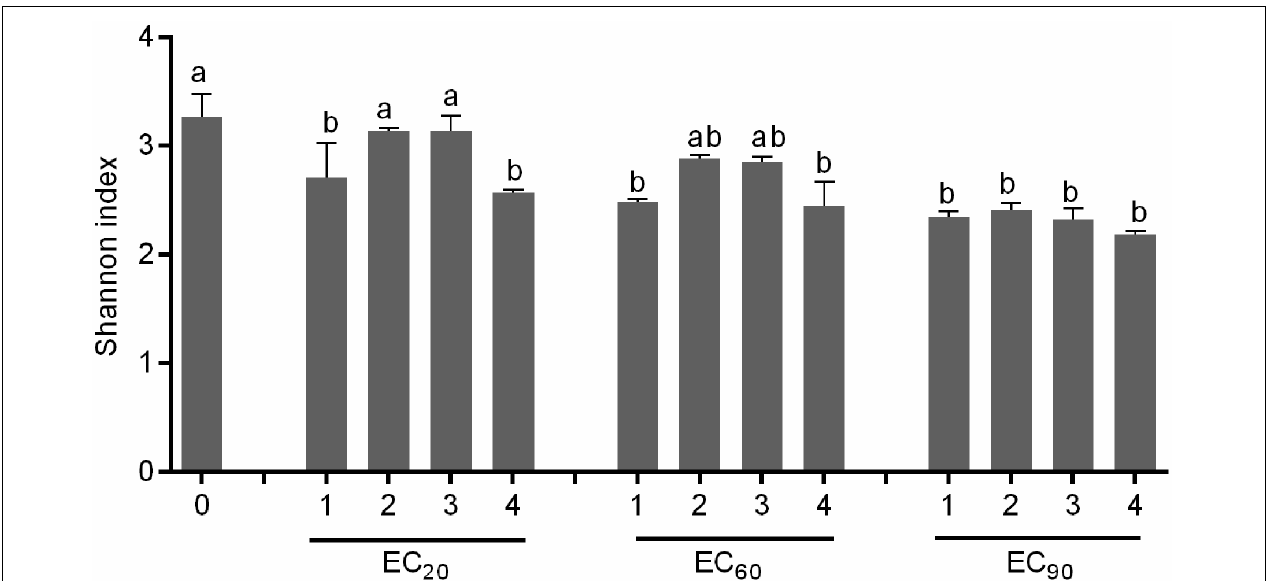
FIGURE 3 | Functional diversity of microbial communities under the four different AgNPs treatment at the EC 20 , EC 60 , and EC 90 levels. The bars are the standard errors of the means ( n = 3). The different letters above the bar in the same EC level indicate significant differences between different treatments at p < 0.05 level (0-control, 1:50–80 nm nanoplates, 2:15 nm nanospheres, 3:20–40 nm nanospheres, and 4:50 nm